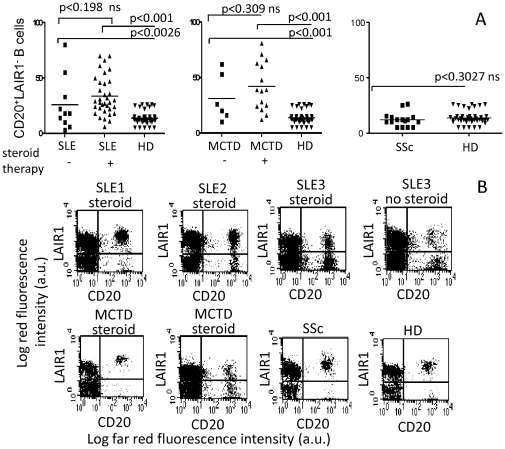
Expression of LAIR1 on PBMC from SLE or RA or SSc patients and HD.A. Peripheral blood mononuclear cells (PBMC) were isolated from SLE (n = 50) or RA (n = 14) or SSc (n = 20) patients and stained with anti-LAIR1 mAb and anti-CD20 mAb followed by goat anti-isotype specific GAM conjugated with either PE or Alexafluor647 and goat anti-human sIgM-FITC polyclonal antibody. Results are expressed as CD20+LAIR1− B cells gated on sIgM+ cells. Surface IgM+ B cells were 95–100% of all B cells in PBMC of any population tested. The percentages of CD20+LAIR1− cells present in PBMC of healthy donors (HD) is shown for comparison in each panel (n = 40). A, right panel: Patients suffering from SLE were subdivided in two groups (with or without steroid therapy). The statistical significance of results is shown in each panel. B. Some representative examples of expression of CD20 and LAIR1 on PBMC of SLE in remission phase (SLE1 and SLE2) or in acute phase (SLE flare) or RA or SSc patients and HD. Results are expressed as Log far red fluorescence intensity vs Log red fluorescence intensity. Each dot plot is subdivided into four quadrants representing CD20−LAIR1+ (upper left) or CD20+LAIR1+ (upper right) or CD20−LAIR1− (lower left) or CD20+LAIR1− (lower right) cells respectively.